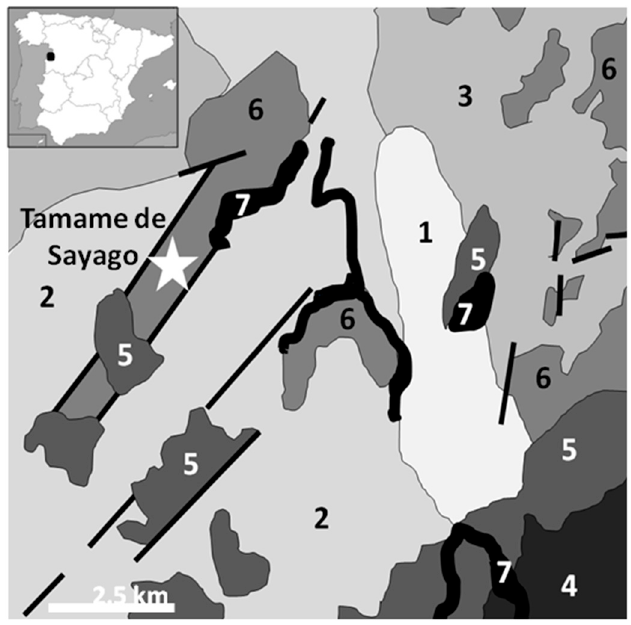
Figure 5. Geological map of the Tamame de Sayago bentonitic deposit. 1, 2, and 3: Variscan granites. 1: Coarse-grain leucogranite; 2: fine-grain leucogranite; 3: coarse-grain biotitic granitoid. 4, 5, and 6: Tertiary sedimentary materials. 4: Sands and lutites with paleosoils; 5: Paleocene siderolithic series with conglomerates, sands, and lutites; 6: Eocene–Oligocene detrital series with conglomerates, sands, and lutites; and 7: Quaternary sediments. Modified from Reference [83].